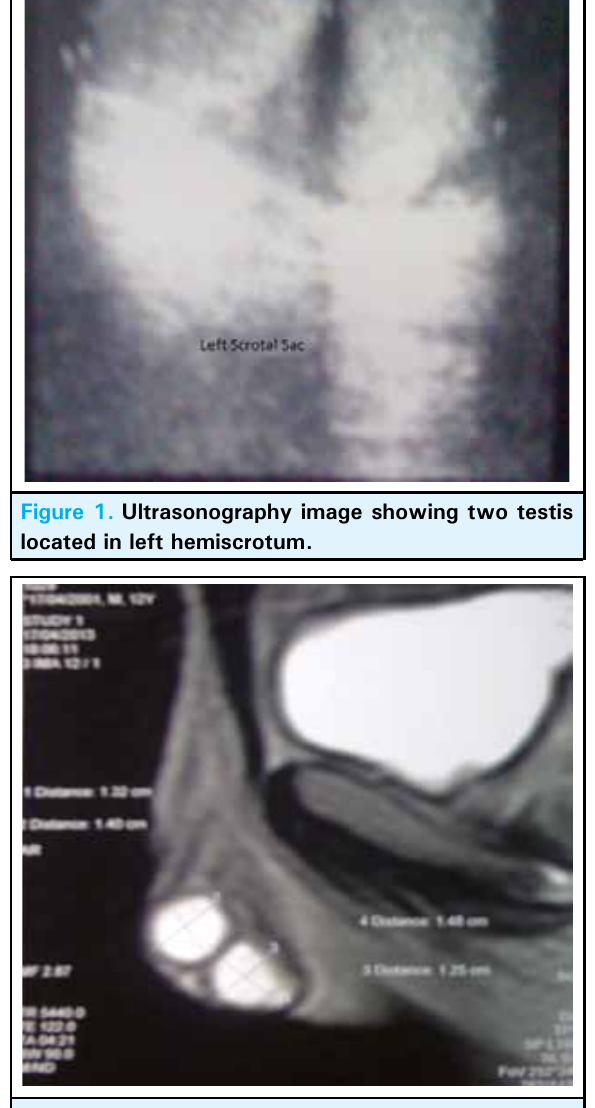
Figure 2. crossed ectopia detected in MrI. sagittal t2 weighted image shows maldescent of right testis in left hemiscrotum. both the testis are of same size and same signal